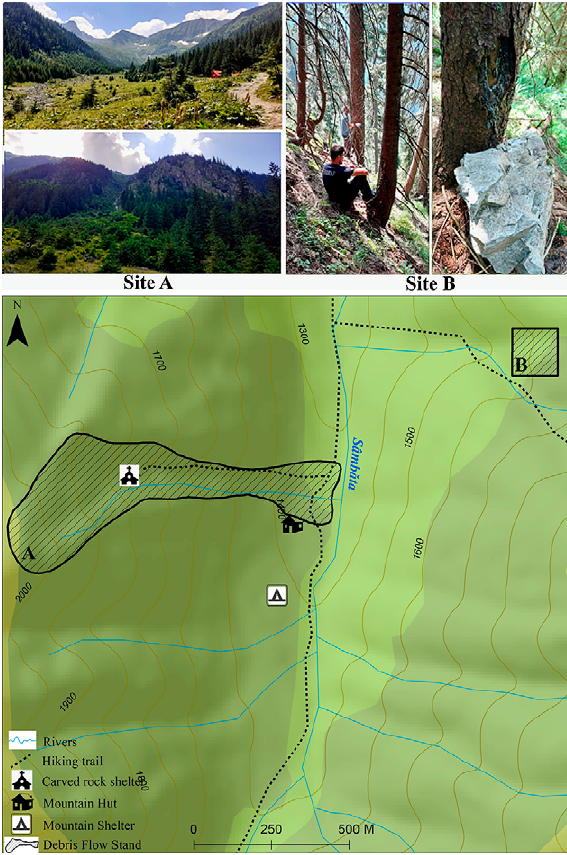
Figure 3. Location of the two analyzed sites in the Sâmbăta Valley (site A - snow avalanches, site B -